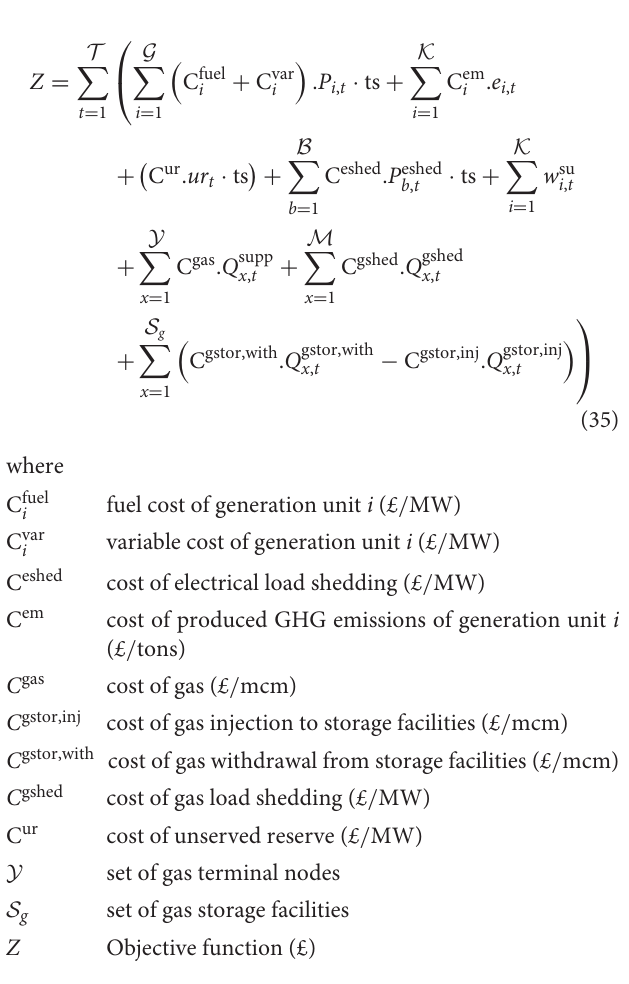
cost of unserved gas demand, and (c) cost of storage facilities and in the electricity system, (a) cost of power generation, (b) emission penalties, (c) unserved reserve, (d) cost of unserved electricity demand, and (e) start-up cost of the generators are taken into account